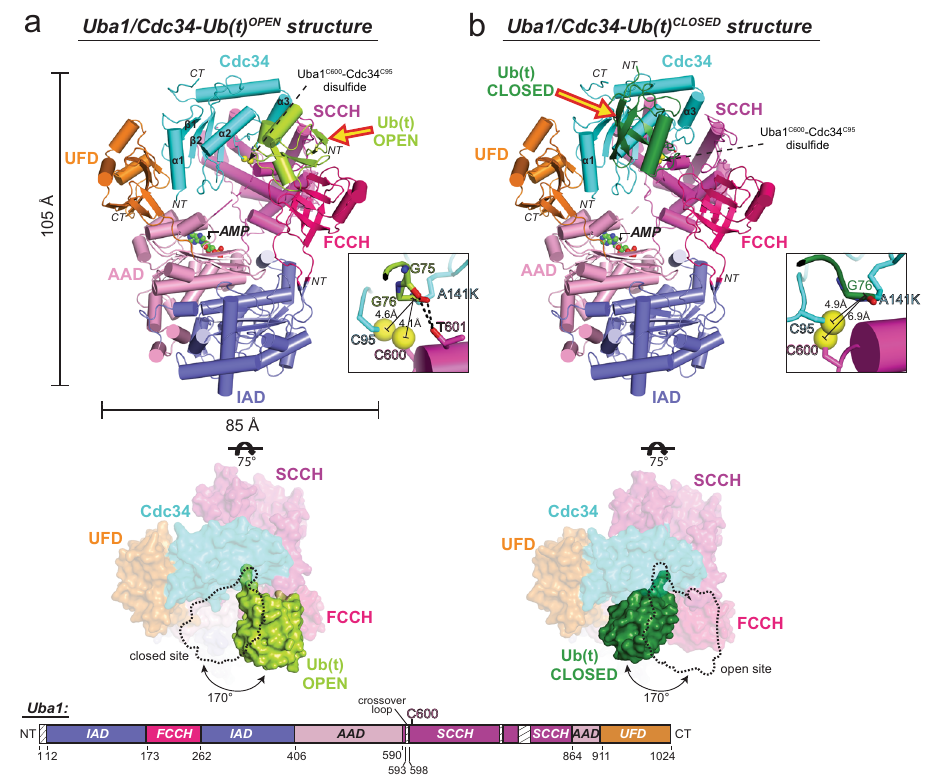
Fig. 2 Overall architecture of Uba1/Cdc34 A141K – Ub(t) OPEN and Uba1/Cdc34 A141K – Ub(t) CLOSED structures. a Top, Side view of the overall Uba1/ Cdc34 A141K -Ub(t) OPEN structure. Uba1 domains are colored and labeled, Cdc34 A141K is colored cyan, Ub(t) OPEN is colored limon. Insets to the right of the structures highlight the relative distances among Uba1 Cys600, Cdc34 Cys95, and Ub(t) Gly76 within the active sites. Middle, The structure is shown from the top down and the fi xed Uba1 – Cdc34 module is shown as a semitransparent surface representation. Ub(t) OPEN is shown as a nontransparent surface representation and the Ub(t) CLOSED binding site is shown with a dashed line to allow for comparison. b Top, Side view of the overall Uba1/Cdc34 A141K – Ub (t) CLOSED structure, Uba1 domains are colored and labeled, Cdc34 A141K is colored cyan, Ub(t) CLOSED is colored forest. The right side illustrations show the relative distances among Uba1 Cys600, Cdc34 Cys95, and Ub(t) Gly76 catalytic sites. Middle, The structure is shown from the top down and the fi xed Uba1 – Cdc34 module is shown as a semitransparent surface representation. Ub(t) CLOSED is shown as a nontransparent surface representation and the Ub(t) OPEN binding site is shown with a dashed line to allow for comparison. Bottom, Schematic representation of Uba1 construct with domains colored as above. Regions of disorder are indicated with a hatched box. Amino acid number is indicated on the